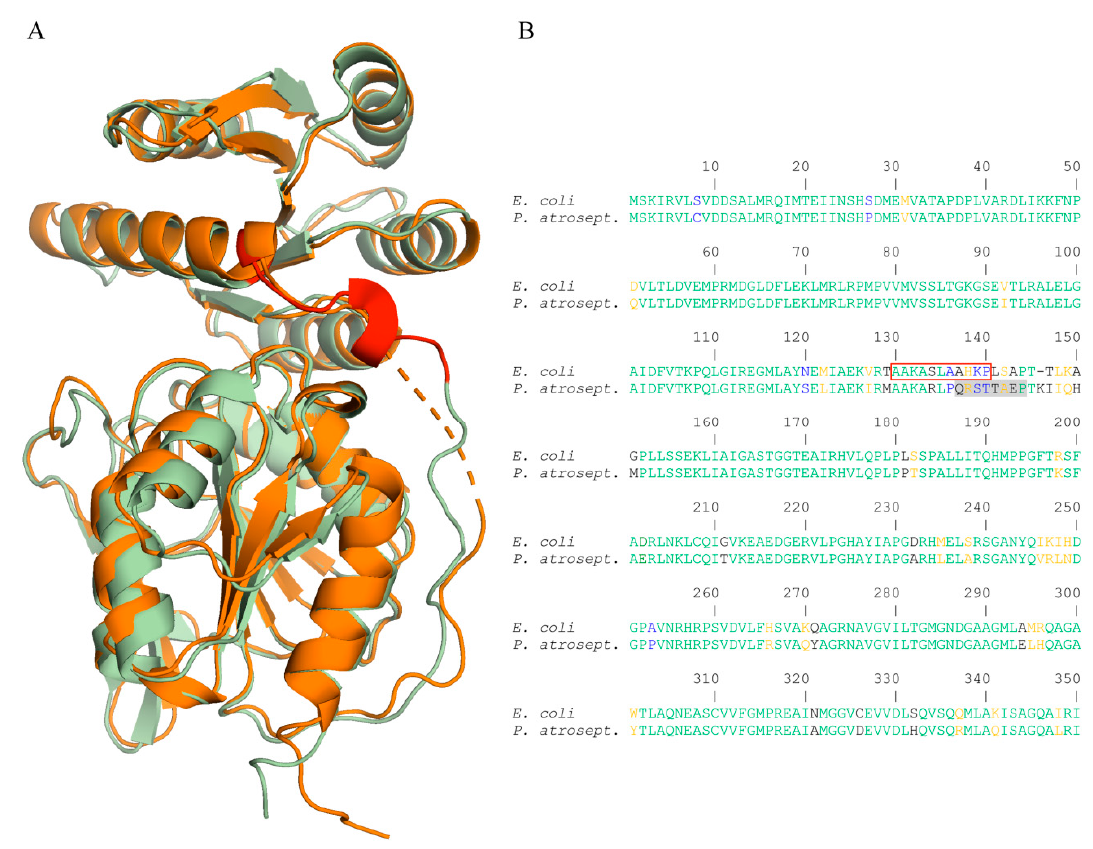
Figure 7. Structural and sequence features related to the capacity of CheB to recognize C-terminal pentapeptides. ( A ) Structural alignment of CheB from P. atrosepticum (orange) and S. enterica sv. Typhimurium (green, PDB ID: 1A2O). The amino acid segment identified as being the pentapeptide-binding site [16] is shown in red. ( B ) Sequence alignment of Escherichia coli K-12 and P. atrosepticum SCRI1043 CheB. The amino acids that form the pentapeptide-binding site in the E. coli enzyme are boxed in red. The gap in the CheB_Pec structure is shaded in grey. The alignment was done using the CLUSTALW algorithm of the NPS@ software [55]. The Gonnet protein weight matrix was used; gap opening and gap extension penalties were 10.0 and 0.1, respectively. Residues in green are identical, orange highly similar, blue weakly similar, and black dissimilar.